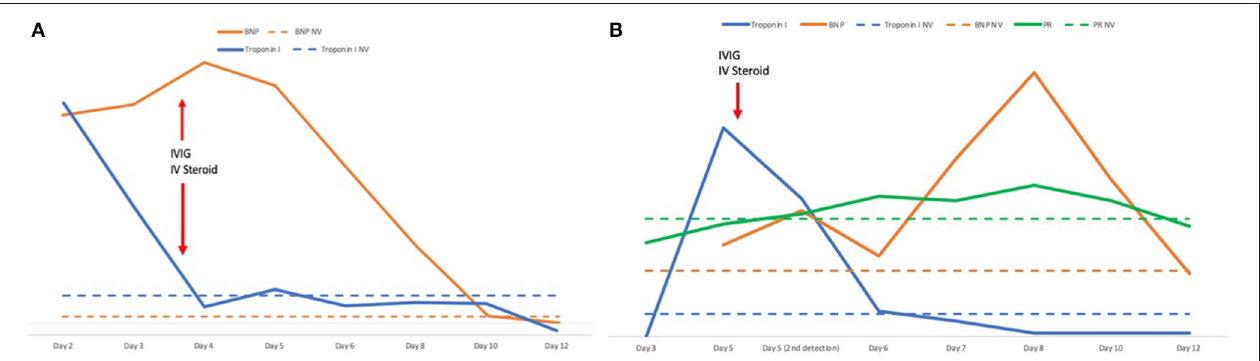
FIGURE 2 | (A) Timeline of tropinin and BNP levels and therapy with IVIG and steroids in case 1. (B) Timeline of troponin, BNP levels, PR interval and therapy with IVIG and steroids in case 2. The number of days refers to the onset of the fever. BNP, brain natriuretic peptide; IVIG, intravenous immunoglobulins; IV, intravenous; NV, normal values.